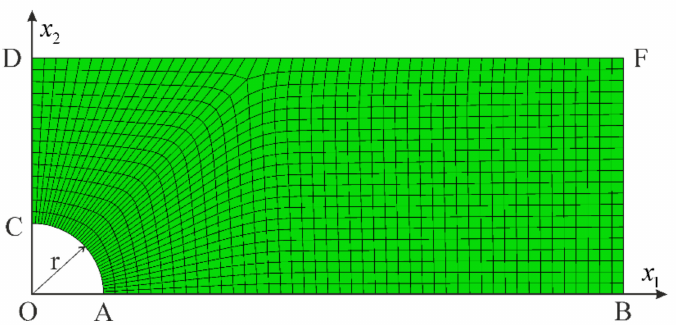
Figure 15. FEM mesh and characteristic points of the rectangular plate with a circular